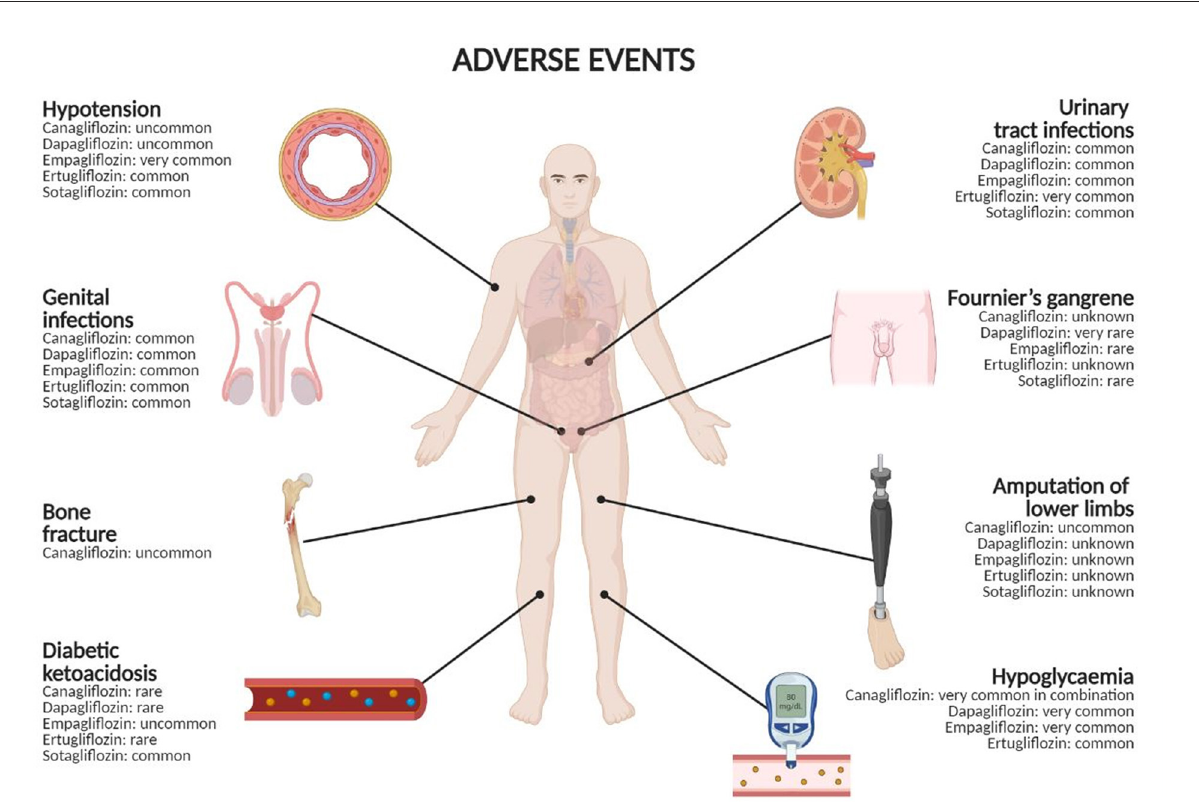
FIGURE1 Adverse events with SGLT2 inhibitors and their frequencies. Frequency categories are defined according to the following convention: very common ( ≥ 1/10), common ( ≥ 1/100 to < 1/10), uncommon ( ≥ 1/1,000 to < 1/100), rare ( ≥ 1/10,000 to < 1/1,000), very rare ( < 1/10,000), unknown (cannot be estimated from the available data). Created in